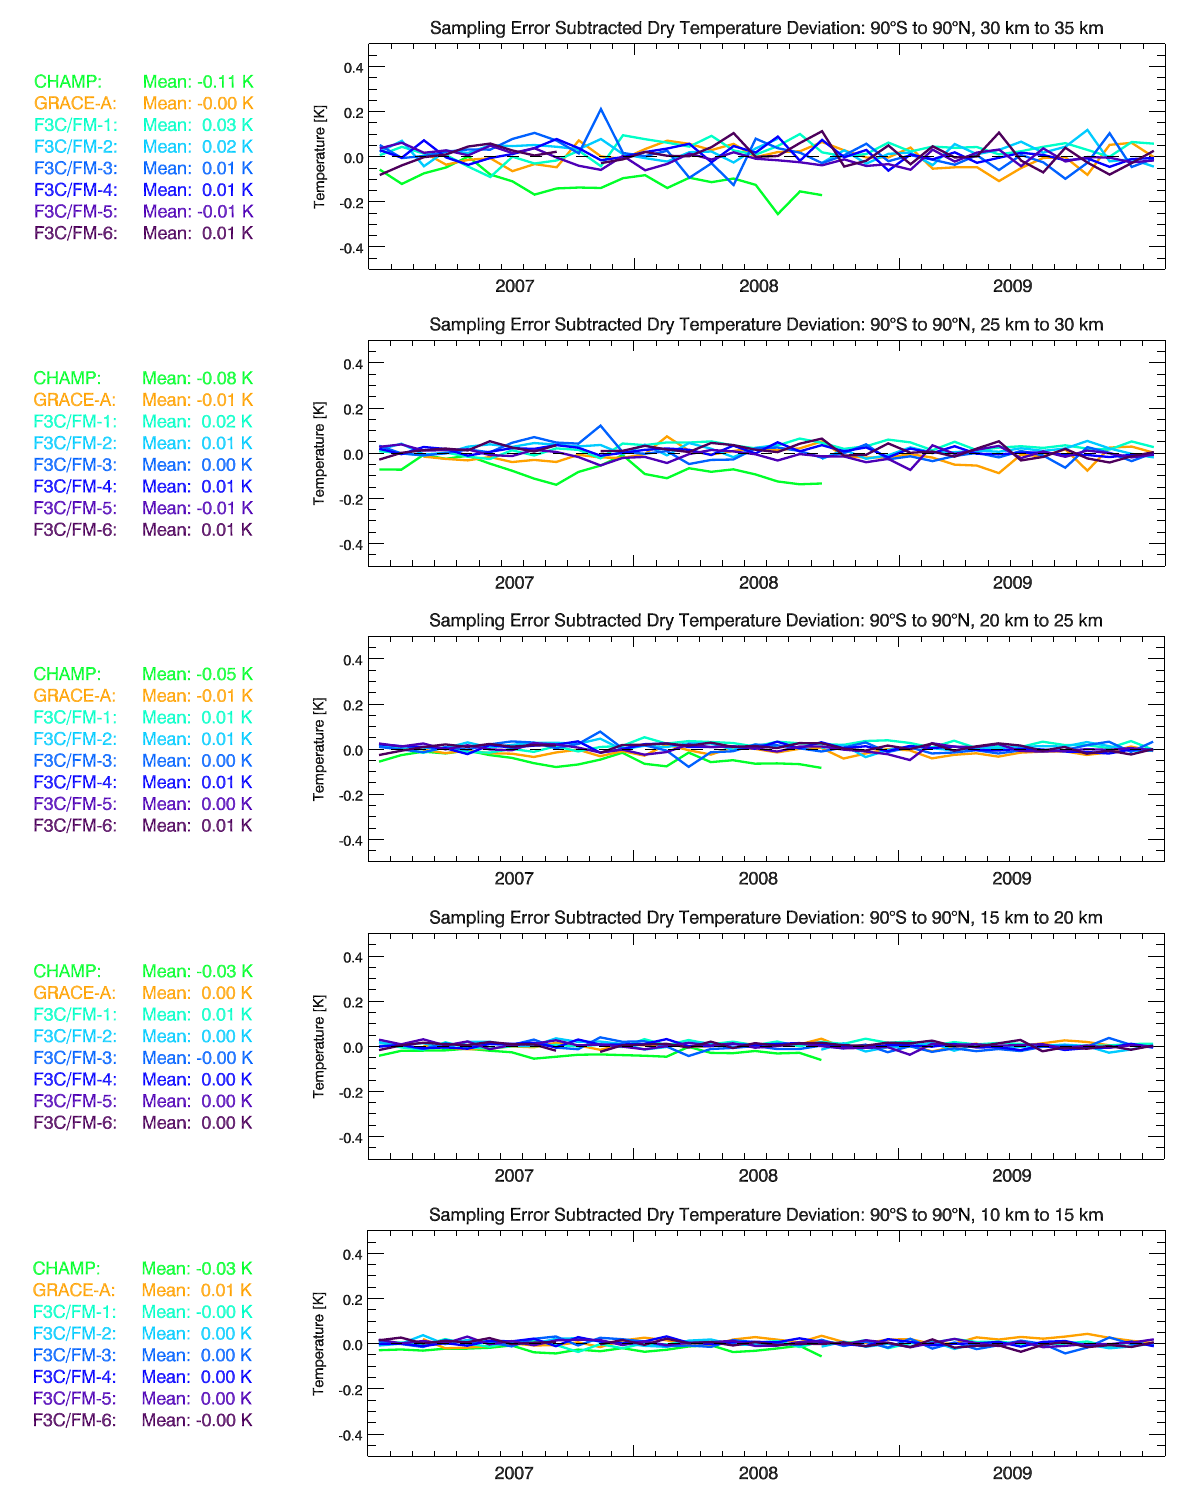
Fig. 6. Same layout as in Fig. 5 (see that caption for explanation) but here showing the dry temperature deviations for the five altitude layers